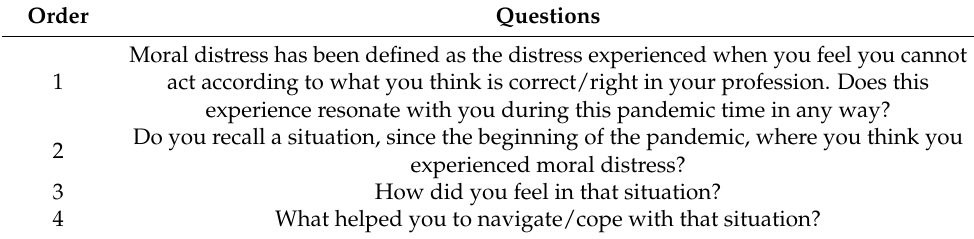
Table 1. Interview